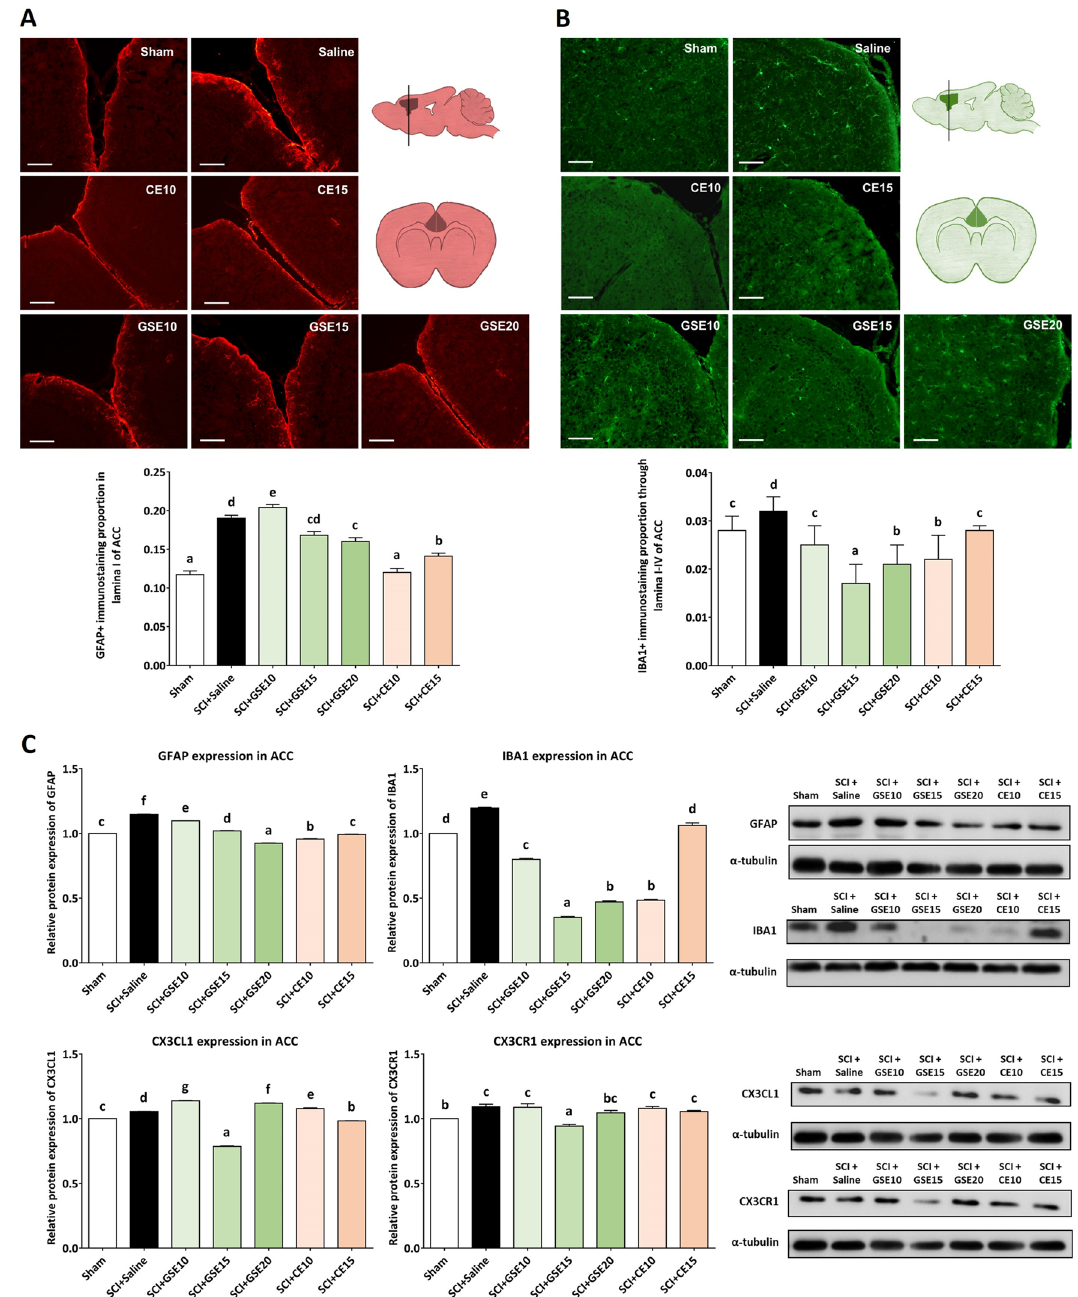
Figure 8. Effects of GSE and CE treatment on gliosis and CX3CL1/CX3R1 expression in the ACC of SCI mice at the end of the experimental period. ( A ) Representative histological images of the ACC immunostained against GFAP of each group (scale bar 200 μm) and histogram representing the proportion of GFAP immunoreactivity in ACC. Data are expressed as the mean ± SEM. ( B ) Representative histological images of the ACC immunostained against IBA1 of each group (scale bar 200 μm) and histogram representing the proportion of IBA1 immunoreactivity in ACC. Data are expressed as the mean ± SEM. ( C ) GFAP, IBA1, CX3CL1 and CX3CR1 expression in ACC. Protein expression was normalized to a-tubulin. Data are expressed as a relative percentage with respect to the sham group (mean ± SEM). Control images were reused either for illustrative purposes or methodological purposes when several protein levels were assessed in one blot. Full-length blots are presented in Supplementary Fig. S6. a–g: Groups not sharing a letter showed significant differences, p < 0.05. Experimental groups: Sham (GFAP n = 5; IBA1 n = 5; CX3CL1 n = 4; CX3CR1 n = 4), SCI + saline (GFAP n = 5; IBA1 n = 5; CX3CL1 n = 4; CX3CR1 n = 4), SCI + GSE10 (GFAP n = 5; IBA1 n = 5; CX3CL1 n = 4; CX3CR1 n = 4), SCI + GSE15 (GFAP n = 5; IBA1 n = 5; CX3CL1 n = 4; CX3CR1 n = 4), SCI + GSE20 (GFAP n = 5; IBA1 n = 5; CX3CL1 n = 4; CX3CR1 n = 4), SCI + CE10 (GFAP n = 5; IBA1 n = 5; CX3CL1 n = 4; CX3CR1 n = 4), SCI + CE15 (GFAP n = 5; IBA1 n = 5; CX3CL1 n = 4; CX3CR1 n =